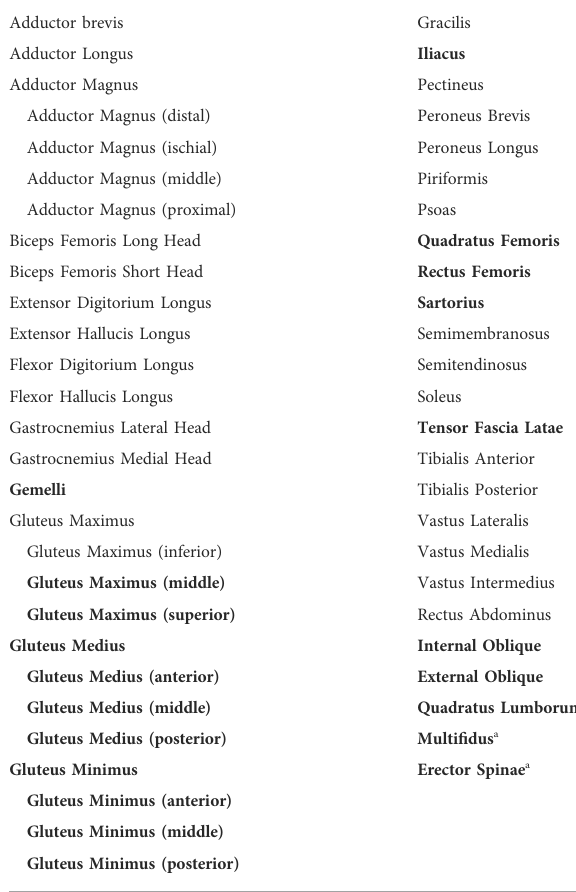
TABLE 3 Muscles included in the enhanced base OpenSim musculoskeletal model. Muscles listed in bold text were removed from the operated side of the model when generating post-surgery walking